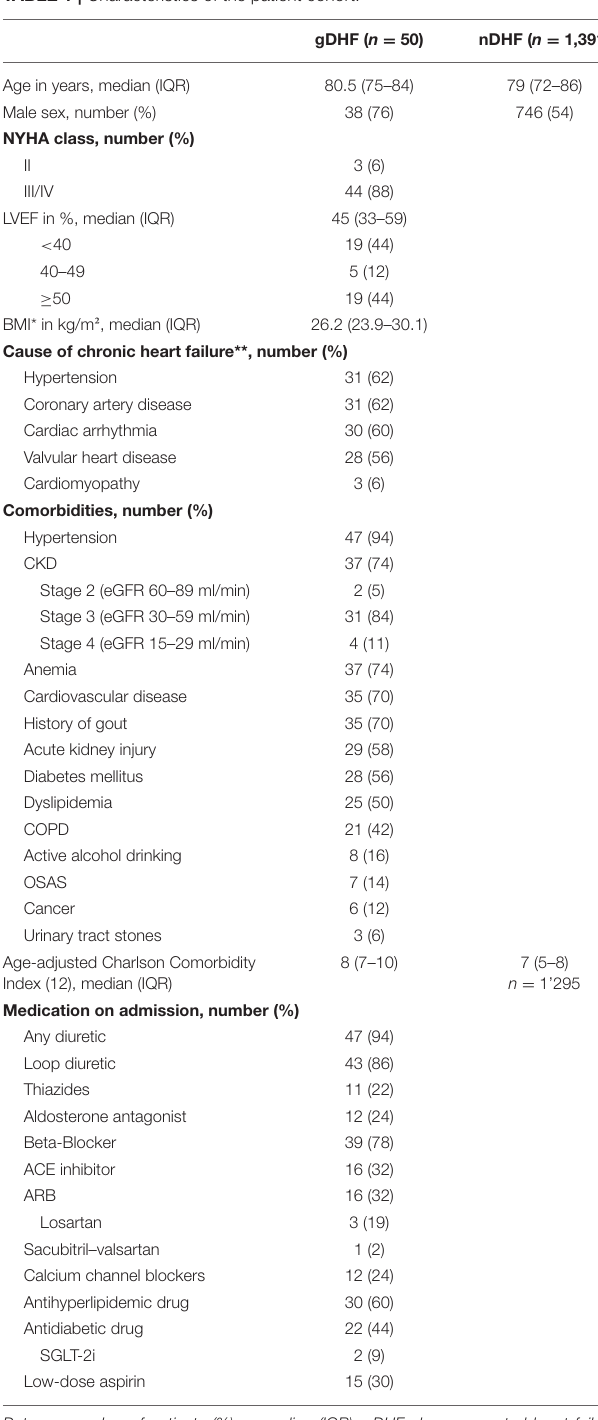
TABLE 1 | Characteristics of the patient